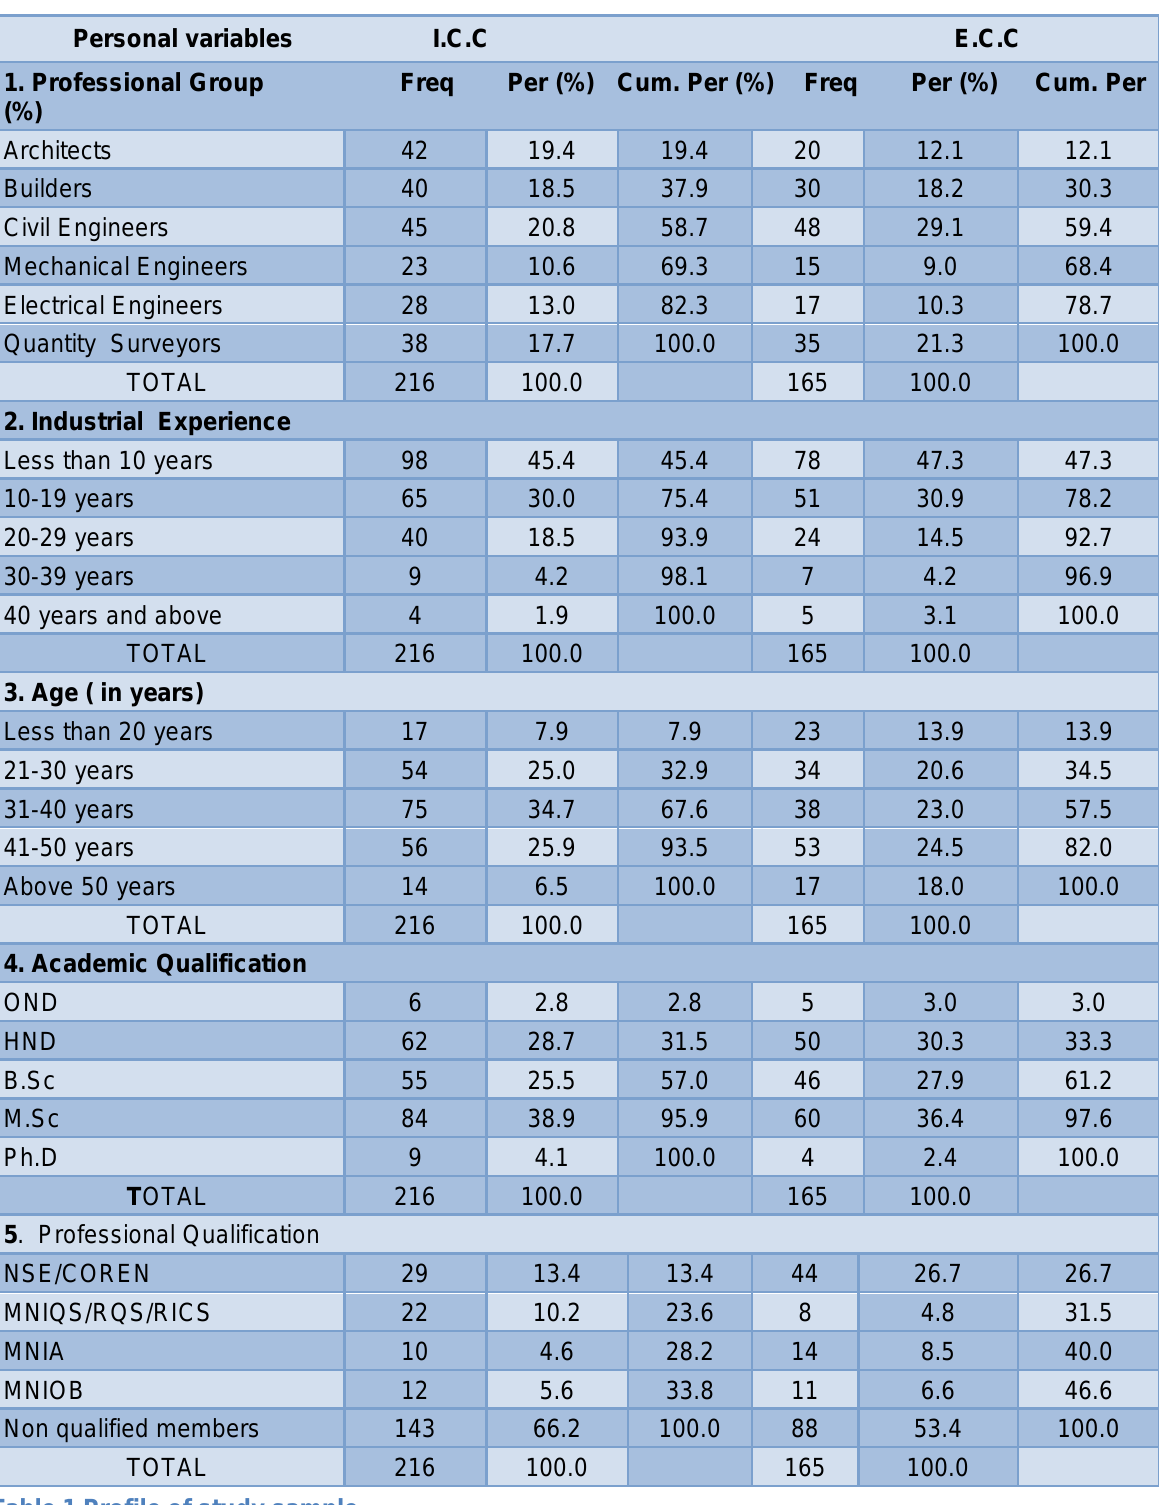
Table 1 Profile of study